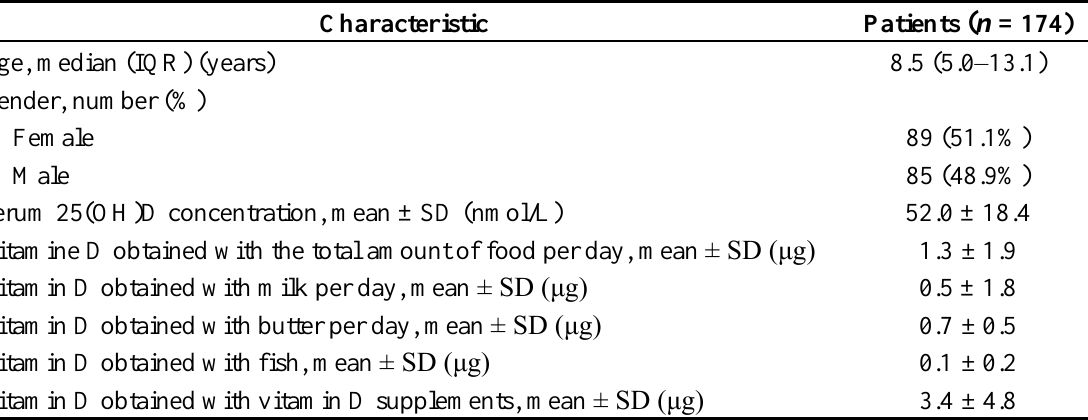
Table 1. Baseline